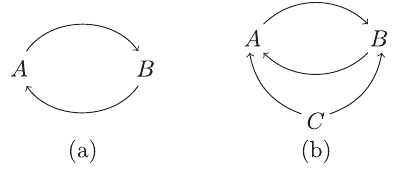
Fig. 2 Examples of cyclic directed graphs. a A cyclic directed graph that does not admit a faithful quantum causal model; b A cyclic directed graph that admits a faithful quantum causal